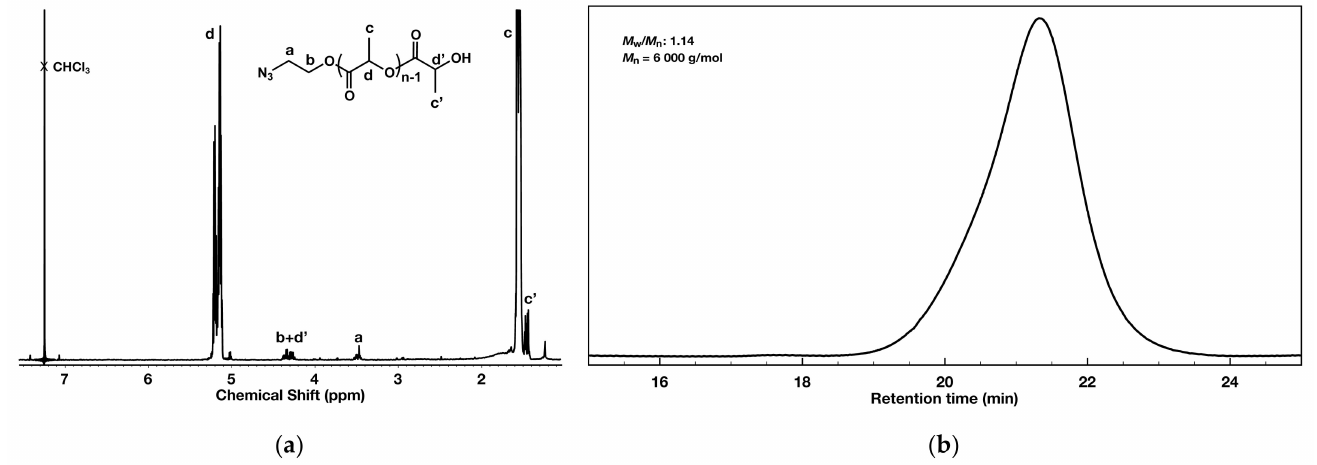
Figure 1. PLA-N 3 polymer characterization via: ( a ) 1 H NMR (600 MHz) spectroscopy in CDCl 3 ; ( b ) GPC in tetrahydrofuran vs. polystyrene narrow-molar-mass